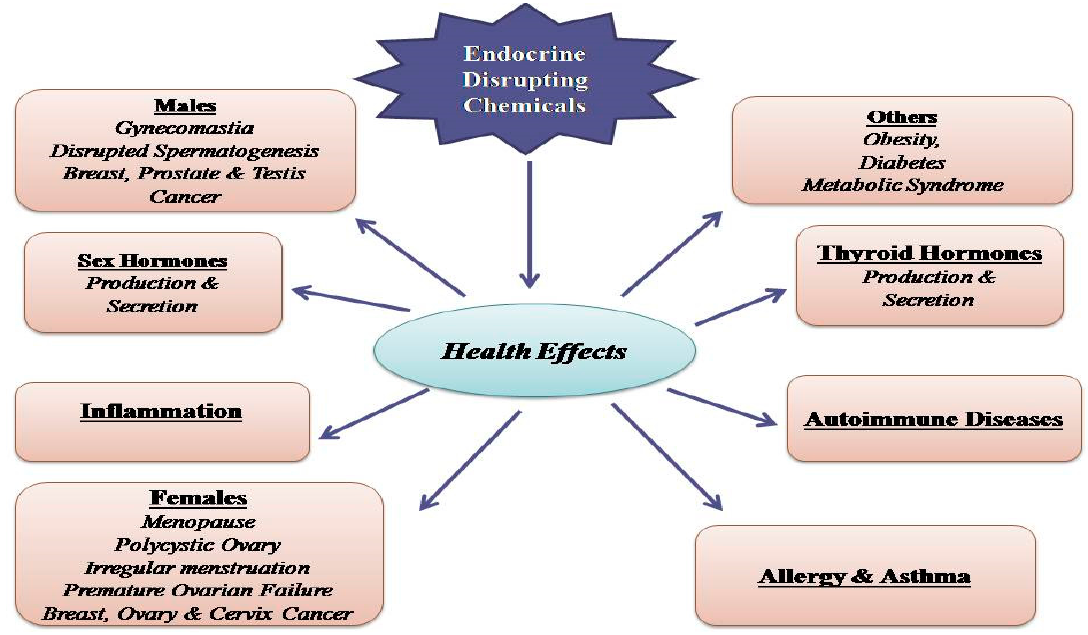
Figure 1. E ff ects of Phthalates on Human Figure 1. Effects of Phthalates on Human Body.